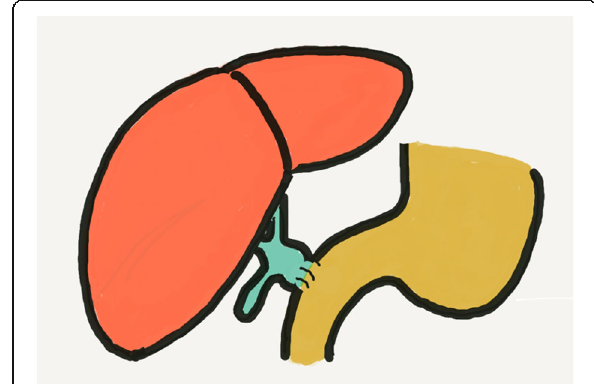
Fig. 1 Cystoduodenostomy was performed for biliary atresia of a type I cyst at age 3 months. The gallbladder was not removed during the initial surgery